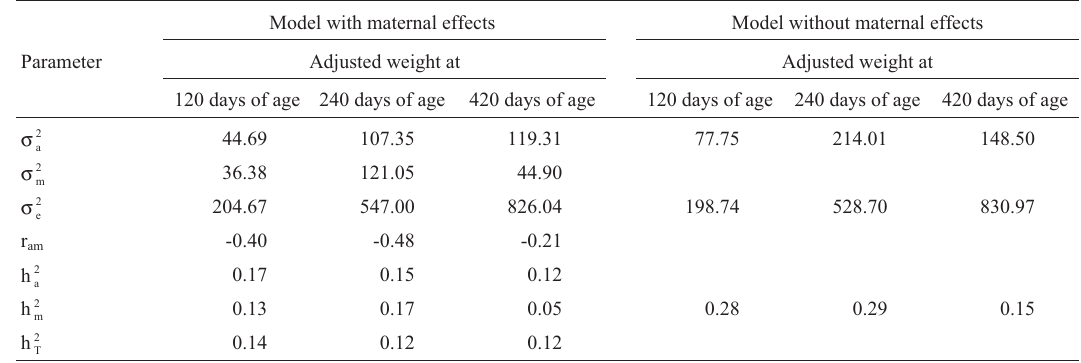
age.**p < 0.01. Table 3 - Estimates of additive direct ( σ a2 ), maternal ( σ m2 ) and residual ( σ e2 ) variances, direct maternal genetic correlations (r (h m2 ) and total (h T2 ) heritabilities obtained by single trait analyses.